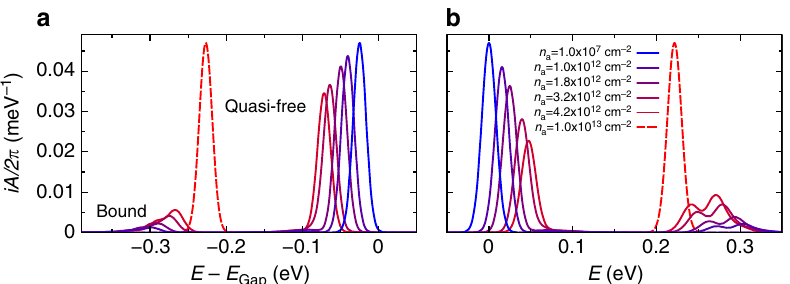
Fig. 4 Energy distribution and relative weight of the exciton and quasi-free-carrier contributions represented by the spectral function. For increasing excitation density and a temperature of 300 K, the spectral function is determined in extended quasi-particle approximation for spin-down electrons ( a ) and spin-up holes ( b ) at the K -point in WS 2 on SiO 2 substrate. A phenomenological Gaussian broadening of 10 meV (HWHM) is included. Electron energies are measured relative to the quasi-particle band gap at zero excitation density. Hole energies are shown as valence-band energies to match Fig. 1f